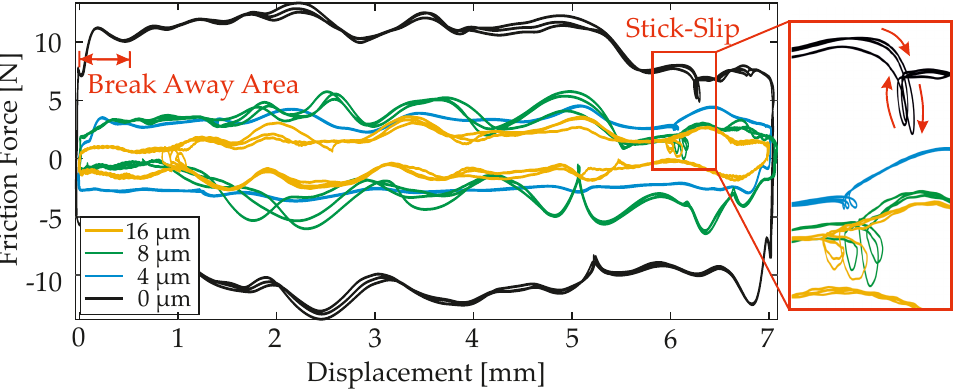
Figure 7. Force − displacement curves for PTFE at v rel of 50